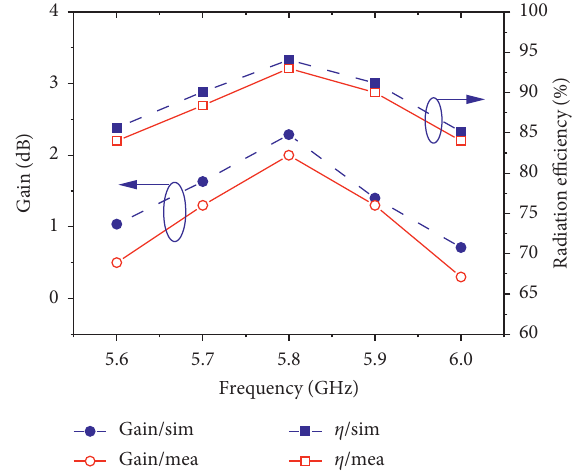
Figure 9: Simulated and measured LHCP gain and radiation